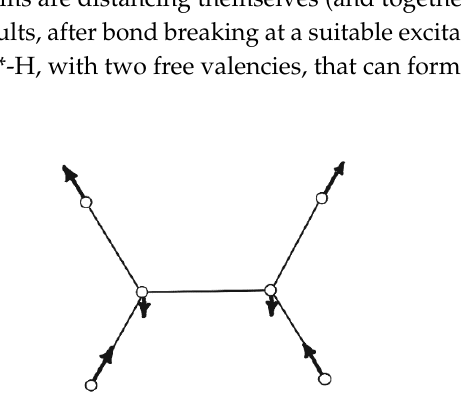
Figure 7. The ν 9 vibration pattern of an X 2 Y 4 planar molecule—let it be C 2 H 4 with the hydrogen atoms in periphery —from part of a scheme by Herzberg (figure 57 in [10] here ν 9 is one out of twelwe symmetry coordinates.).